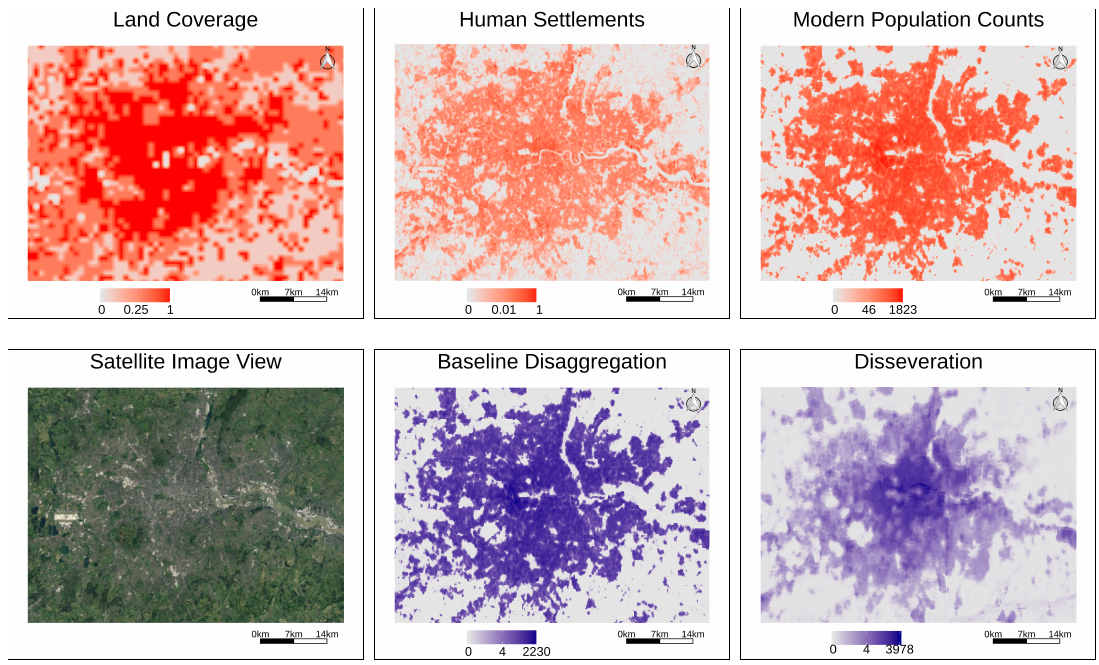
Figure 6. Results for the disaggregation of historical population counts for a region corresponding to the city of London, together with ancillary variables for the same